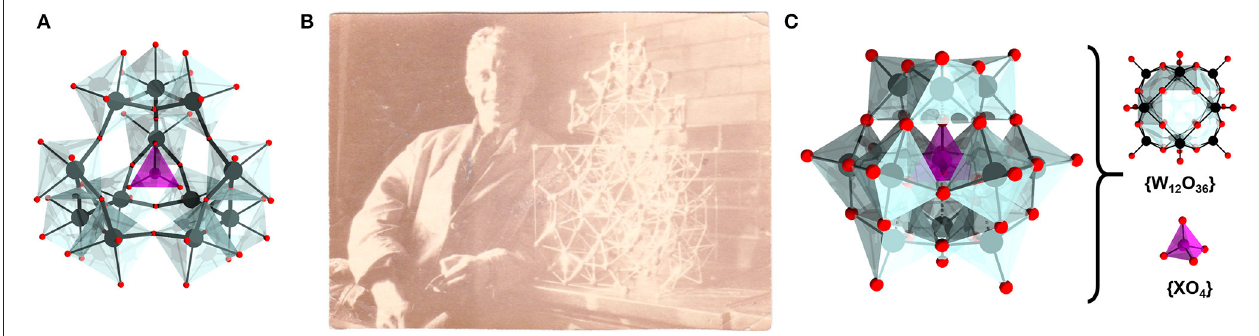
FIGURE 1 | (A) Structural model of Pauling’s {XO 4 }@{W(OH) 3 O 1.5 } 12 model; (B) Photograph of Dr. James F. Keggin; (C) Keggin structure {(XO 4 )@M 12 O 36 } where M = Mo or W showing the different subunits. Color code: M, black; O, red; and X,